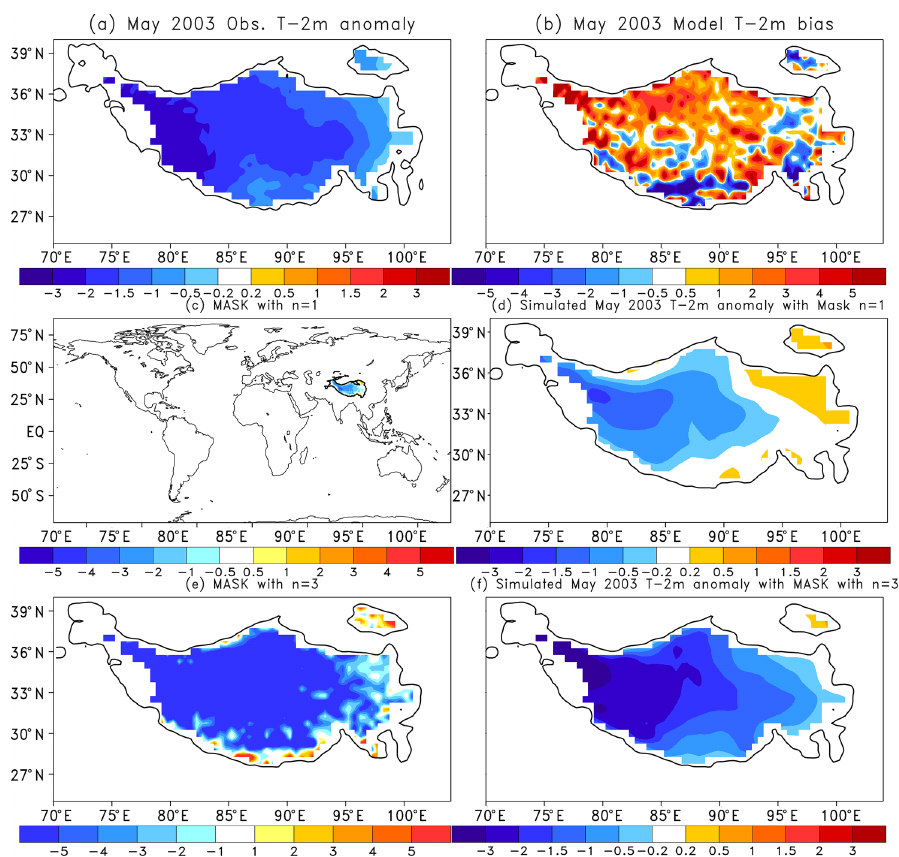
Figure 3. Schematic diagram for the mask application. (a) Obs. May 2003 T -2m anomaly over the Tibetan Plateau (TP), (b) May 2003 T -2m simulation bias over the TP from a LS4P model, (c) imposed mask with n = 1 for a LS4P model, (d) simulated May 2003 T -2m anomaly over the TP after imposing the mask shown in (c) , (e) as in (c) but with n = 3 (only the TP is displayed here), and (f) as in (d) but with n =